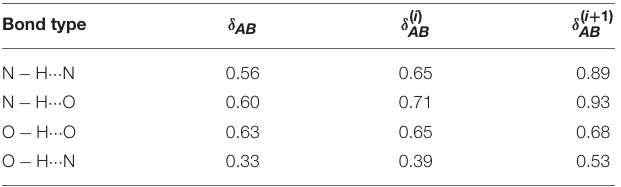
TABLE 2 | Probabilities that the hydrogen bond PMI and the distance–angle definition agree that a point is a hydrogen bond (Equation 6).